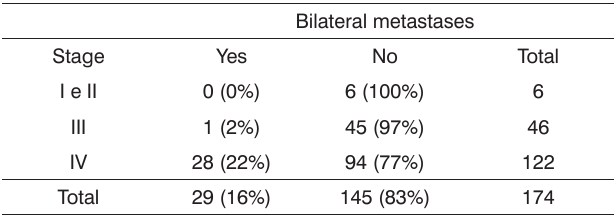
Table 4. Incidence of bilateral histological metastases according to the clinical stage (p=0.003) Bilateral